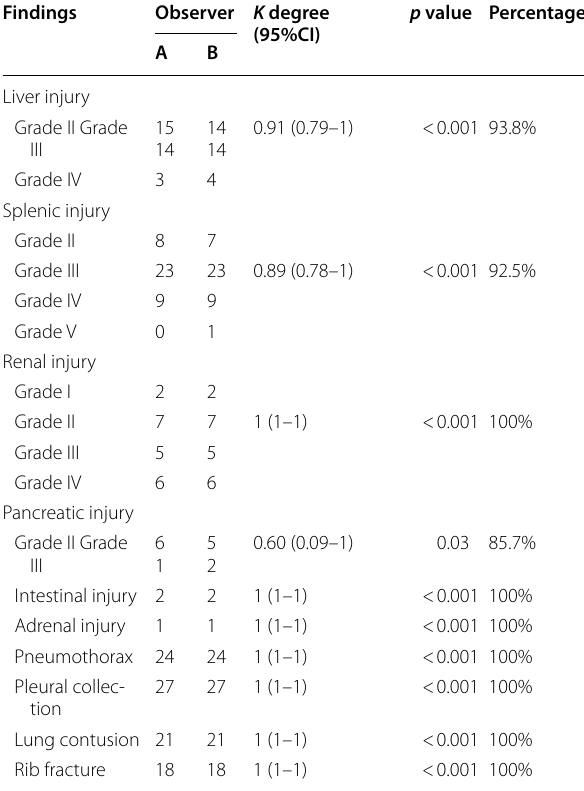
Table 9 Inter‑observer agreement between observer A and B for findings in